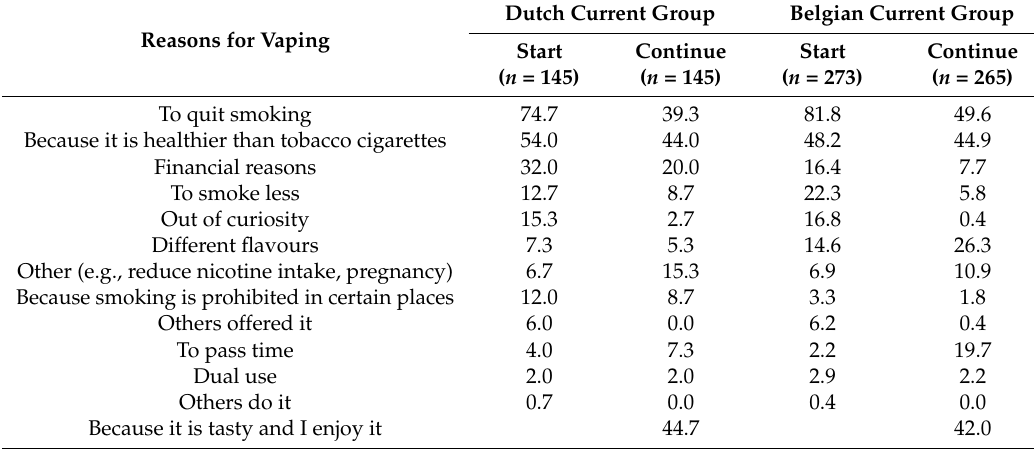
Table 3. Distribution of responses (in %) regarding the reasons for starting to use e-cigs (all participants who had ever used an e-cig) and the reasons for continuing to use e-cigs (all current vapers) for the Dutch Current/Belgian Current